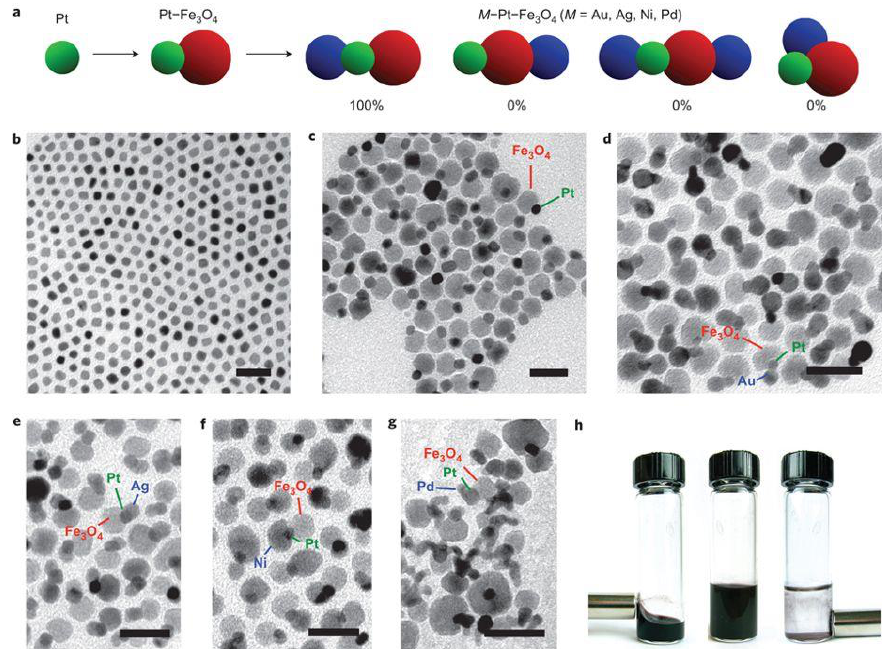
Figure 4. Sequentially seeded growth of M – Pt – Fe 3 O 4 heterogenous nanostructure ( M = Ag, Au, Ni, Pd). ( a ) Schematic illustration of the chemoselective growth of M – Pt – Fe 3 O 4 heterotrimers, along with the most possible products and their observed frequencies. Representative TEM images of ( b ) Pt NP seeds, ( c ) Pt – Fe 3 O 4 heterodimers, ( d ) Au – Pt – Fe 3 O 4 , ( e ) Ag – Pt – Fe 3 O 4 , ( f ) Ni – Pt – Fe 3 O 4 , and ( g ) Pd–Pt–Fe 3 O